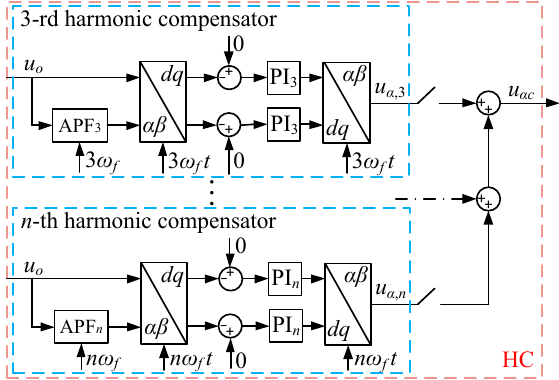
Figure 11. Block diagram of harmonic compensator.